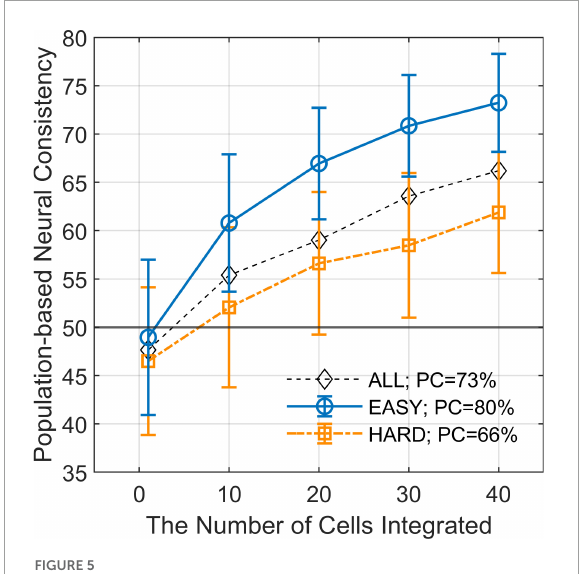
FIGURE5 Population-based neural consistency as a function of the number of cells integrated. The estimated PNCs (mean across simulations) as a function of the number of integrated neurons for EASY 50 stimuli (blue circles), HARD 50 stimuli (orange squares), and for all stimuli (black diamonds). The error bars indicate SDs. The simulation was repeated 200 times for every condition with randomization. The difference in PNC between EASY stimuli and HARD stimuli increases as the number of integrated neurons increases when FG neurons were